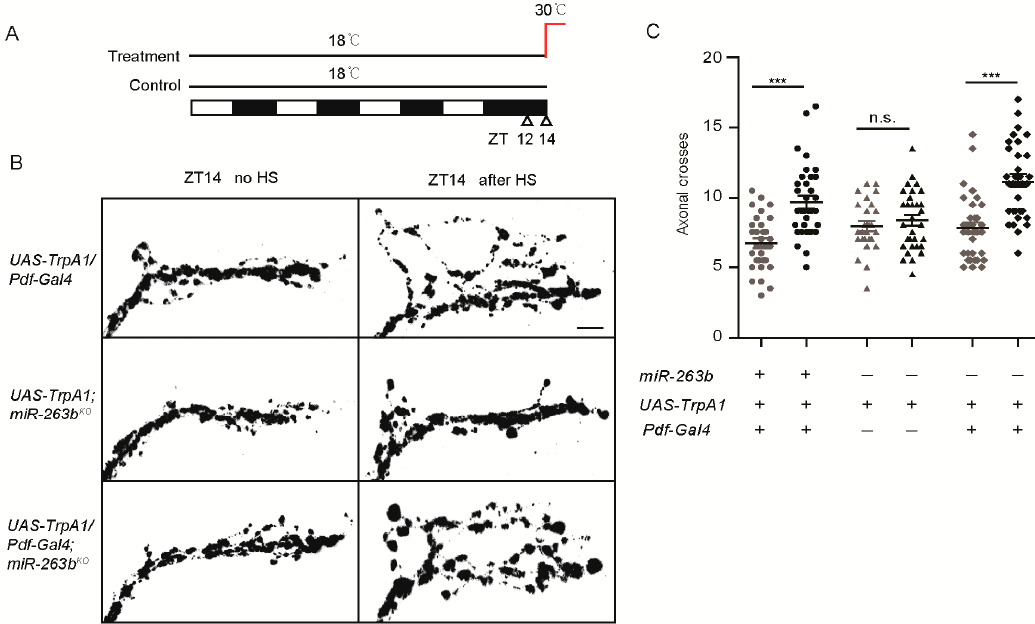
Figure 3. Activity-dependent remodeling of sLNv axonal fasciculation is intact in miR-263b KO flies. ( A ) Diagram of activity induction by heat. Flies were raised at 18 °C and entrained in LD cycles at 18 °C for at least three days before shifting to 30 °C at ZT12. Flies were dissected 2 h later (ZT14) for anti-PDF staining. ( B ) Representative confocal images of sLNv projections at ZT14 with or without heat shock (HS). Induction of TrpA1 in PDF cells by 2-h temperature elevation to 30 °C leads to open conformation of sLNv dorsal projections at ZT14 in all strains; scale bar, 10 µm. ( C ) Quantification of TrpA1 -induced changes in axonal fasciculation. “+” or “ − ” represents that the relative genes are present or absent in the flies. Data represent means ± SEM ( n = 26–34); n.s. not significant, *** p < 0.001 determined by Student’s t -test.